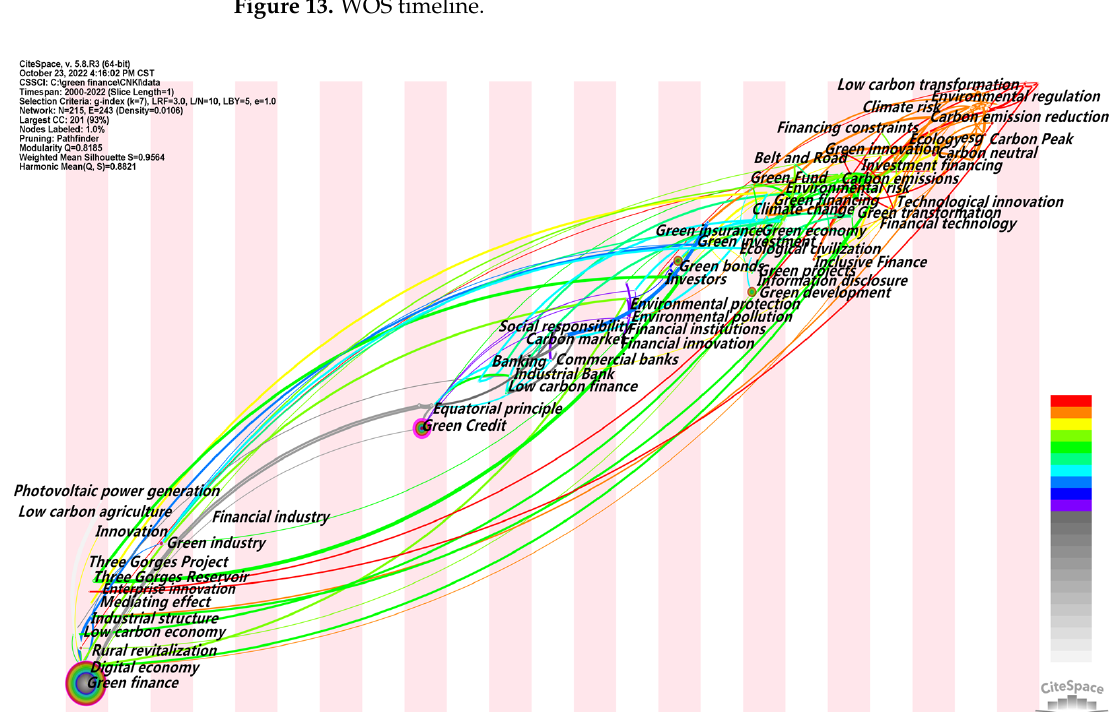
Figure 13. WOS timeline.